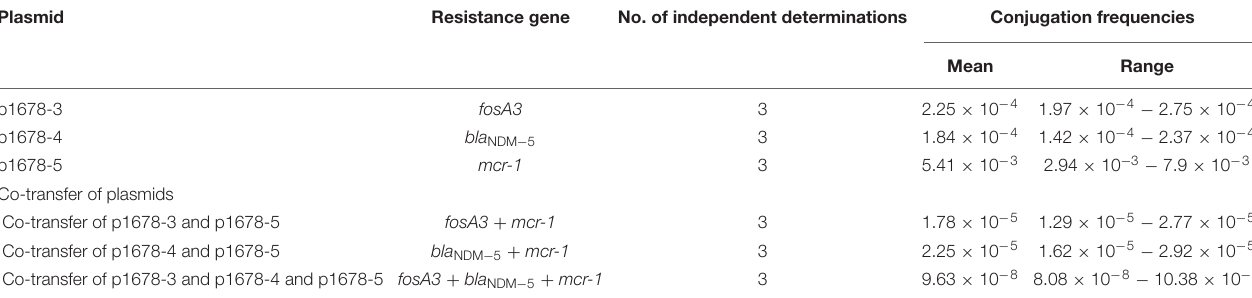
TABLE 3 | Conjugation frequency of resistant plasmids identified in K. pneumoniae 1678. Plasmid Resistance